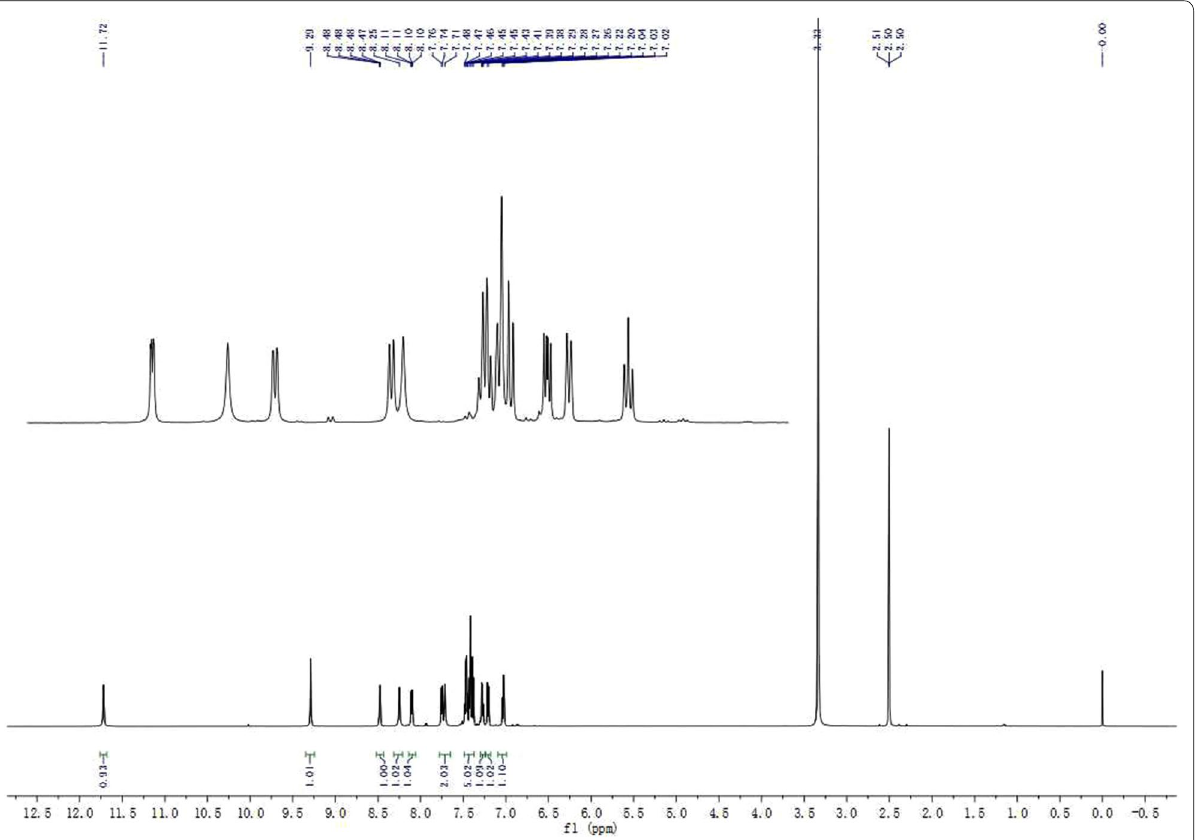
Fig. 3 The representative 1 H NMR spectra analyses for compound